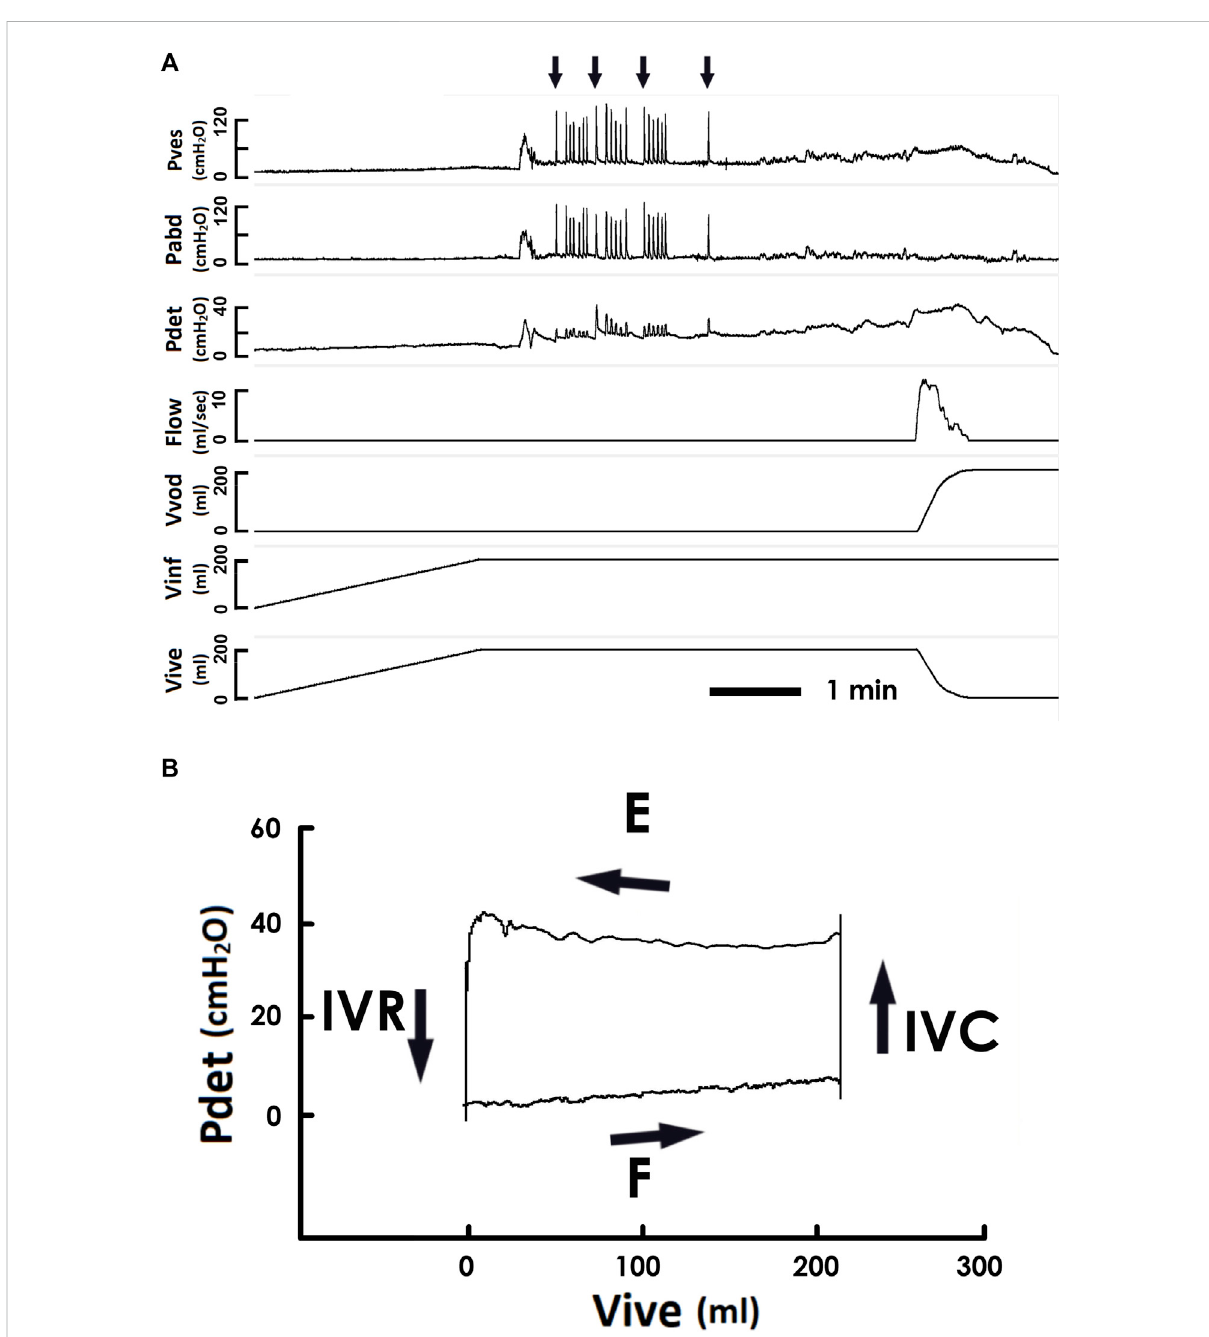
FIGURE 2 Pressure- fl ow/-volume analyses of a voiding. (A) a representative cystometry of a SUI patient. Arrows on the top indicate coughs. Pves is the vesical pressure, Pabd abdominal pressure, Pdet detrusor pressure, Flow urethral fl ow, Vvod voided volume, Vinf infused volume, and Vive is intra- vesical volume. (B) a pressure-volume analysis established by plotting the Pdet versus Vive. The trajectory of pressure-volume data moves counterclockwise and shapes an enclosed loop representing a voiding cycle. Four phases are identi fi ed in the pressure-volume loop, namely (Abrams et al., 2003) fi lling (F) (Abrams et al., 2002), iso-volumic contraction (IVC), (Sahin et al., 2022), emission (E), and (Kaya et al., 2015) is iso- volumicrelaxation(IVR).Orthogonalprojectionsofthetopandbottomtrajectoriesontotheabscissarepresentedthevoidedandinfusedvolumesof a voiding cycle. Although coughs induce marked fl uctuations in the vesical and abdominal pressure in the cystometry, they exhibit low in fl uence on the pressure-volume